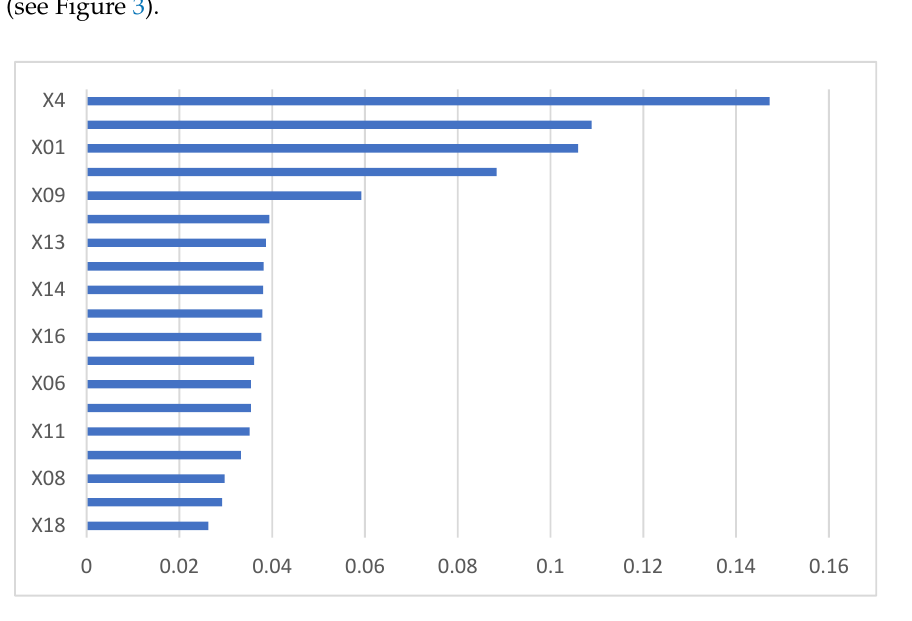
Figure 3. The Gini index of initial indexes.